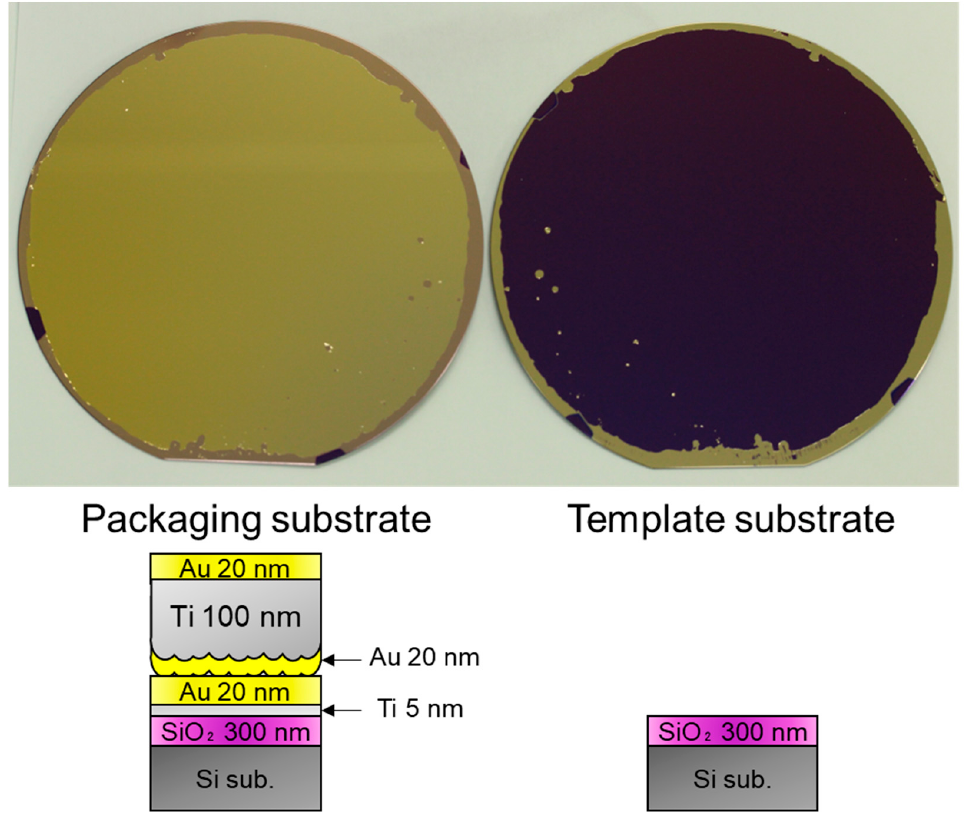
Figure 6. Packaging and template wafers after transferring the Au/Ti/Au layer.